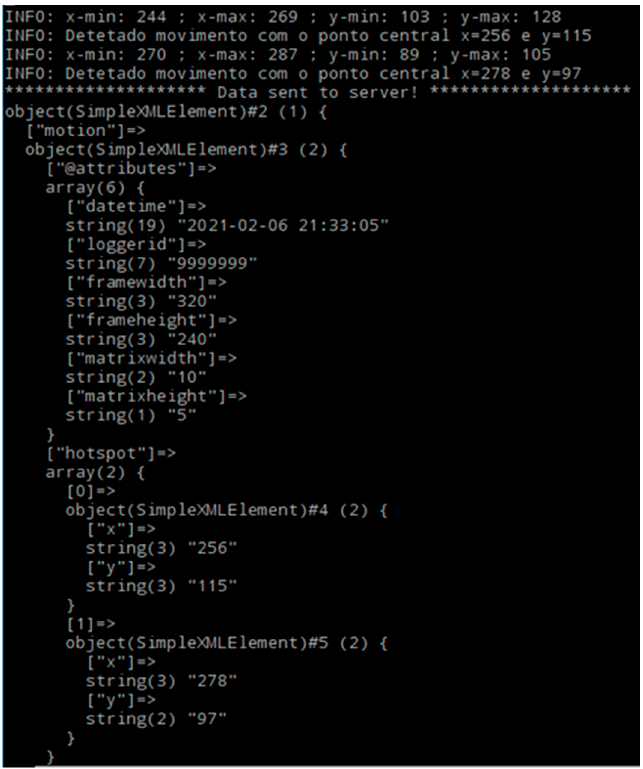
Figure 14. Monitoring Agent output in debug mode.